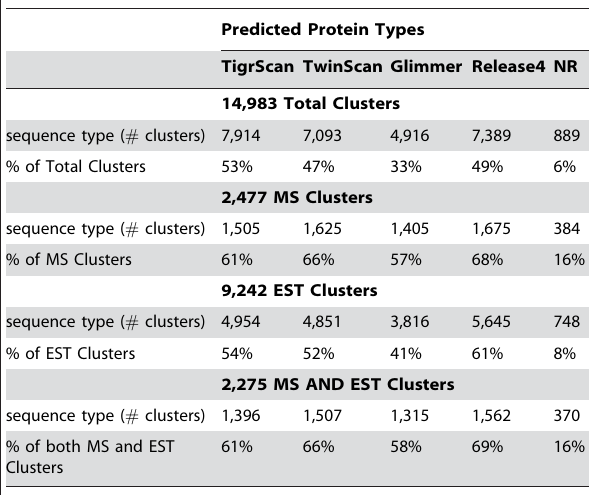
Table 4. Distribution of cluster sizes (number of sequences per cluster) for the CD-HIT clustered combined protein dataset.